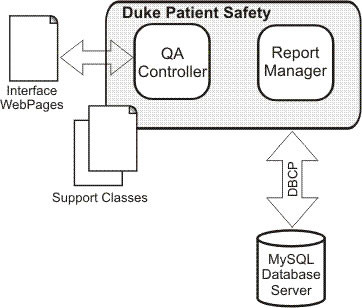
DSPS architecture.